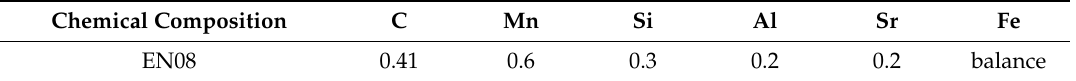
Table 1. Chemical composition of EN08